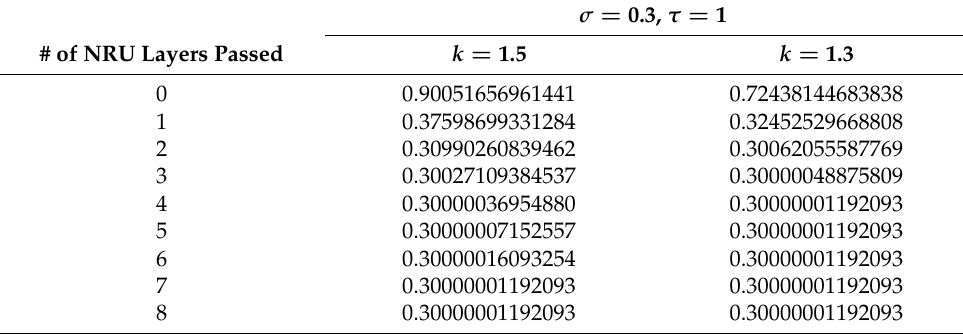
Table 5. Change in the predicted value of the NR neural network according to the number of NRU layers